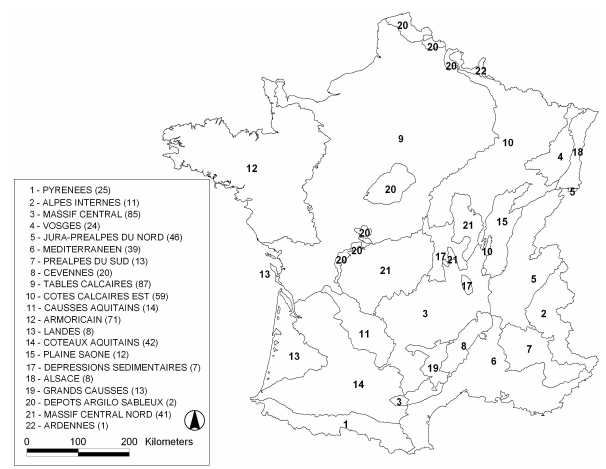
Fig. 1. France showing the hydro-ecoregion (HER) boundaries (Wasson et al., 2002). The number of gauging stations included in this study in each region is shown in parentheses in the